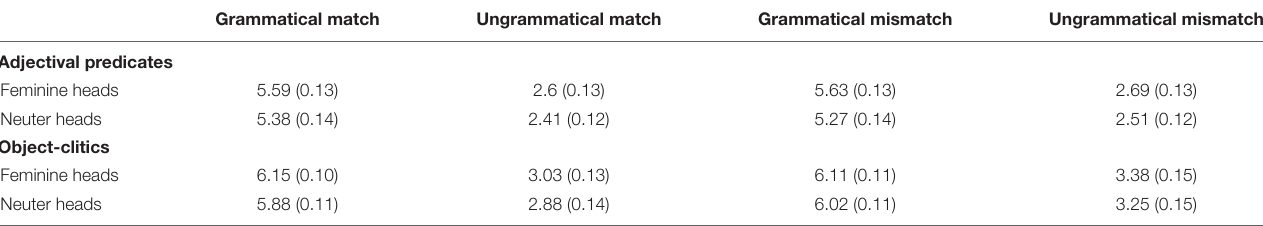
TABLE 9 | Linear mixed-effects model results of participants’ ratings in adjectival predicates and object-clitics in Experiment 4. Feminine